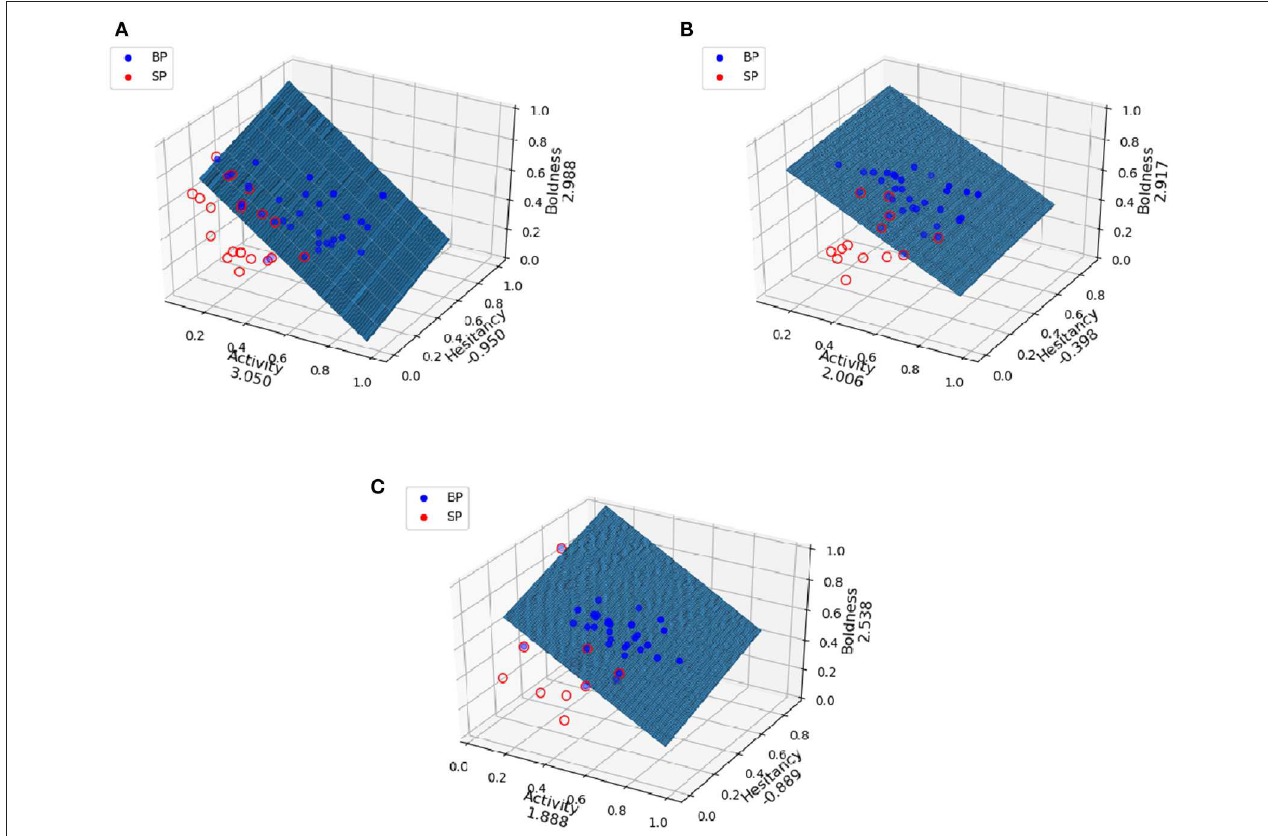
FIGURE 6 | Analysis of the influence of the three factors on the swimming crabs personality classification based on SVM. (A–C) The results of analysis at 0, 6, and 12 days starvation. Each axis represents the corresponding factor and its weight or